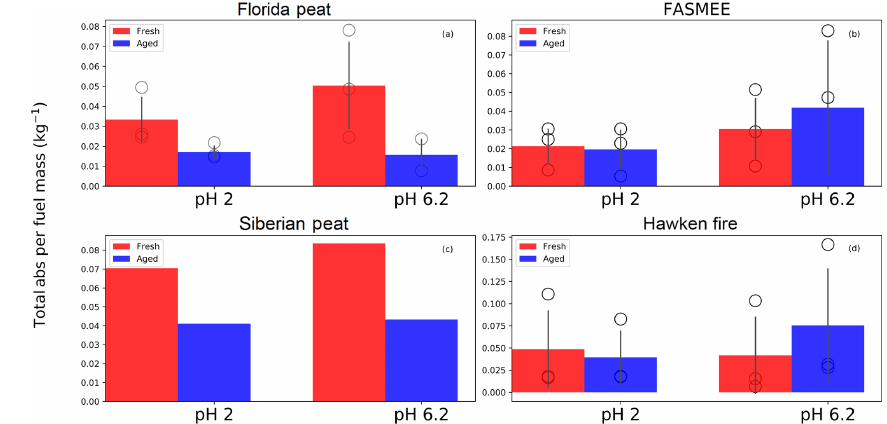
Figure 7. Comparison of total absorbance per fuel mass consumed for the fresh and aged aerosols in water (pH = 6 . 2) and water extracts (pH = 2), normalized to 1mL extraction volumes. Bars, circles, and error bars represent the mean values, individual observations, and standard deviations, respectively. No error bars are given for Siberian peat, because only one experiment was performed with this fuel.